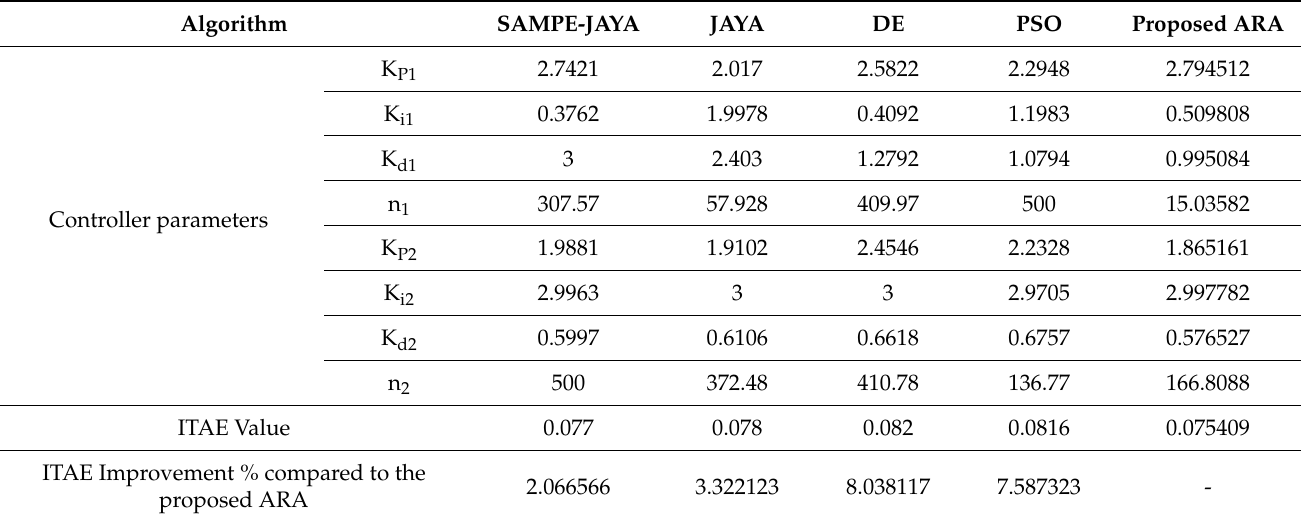
Table 3. Simulation results under Case Study 2.